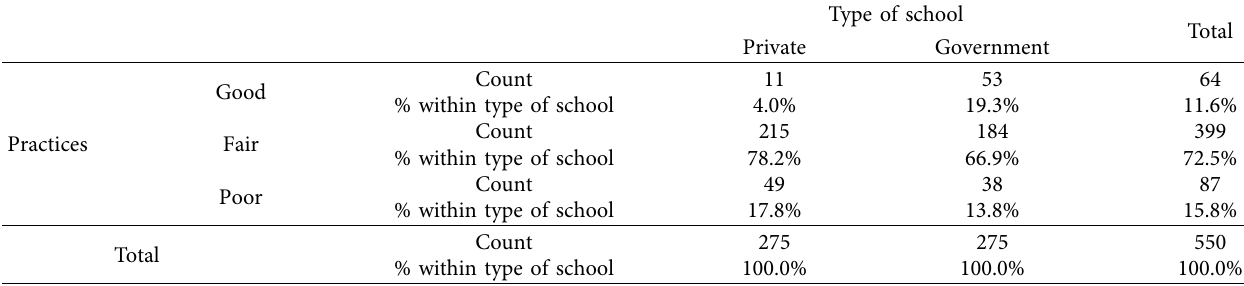
Table 5: Distribution of school teachers based on their practices and type of